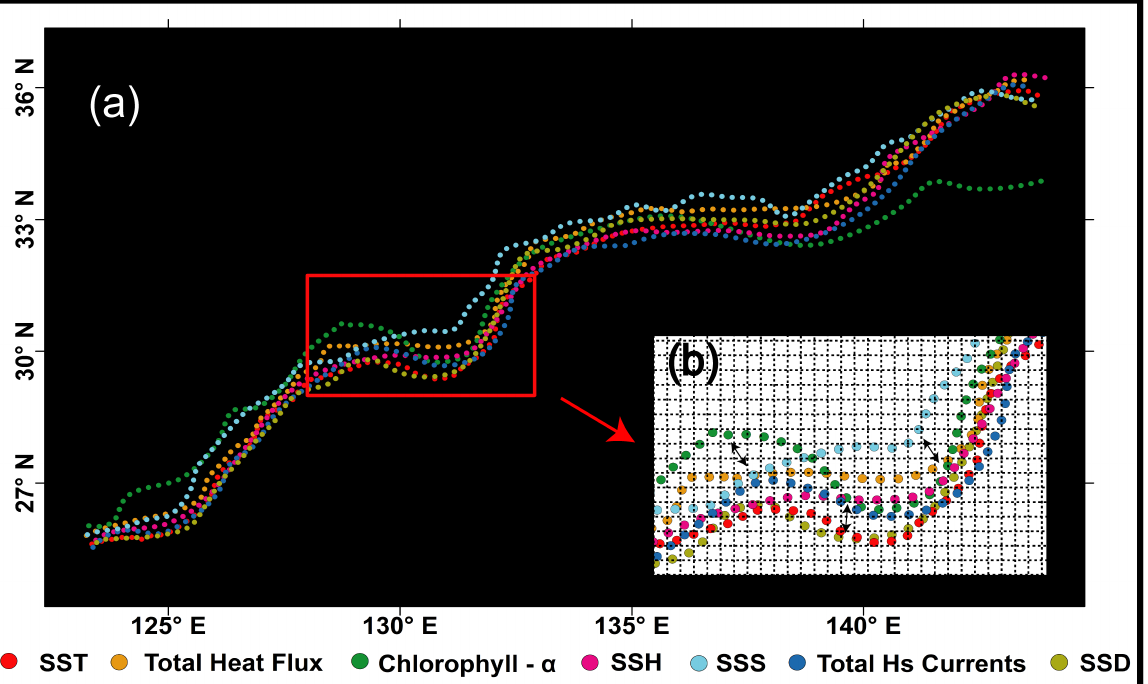
Figure 3. Depicts the computed midpoints from centerlines ( a ) location of vertex in similar column varying with rows; ( b ) sample zoomed segment from red box illustrating the grids from which the latitude and longitude were used to compute distance matrix and slope matrix to analyse spatial variation among the centerlines from all seven